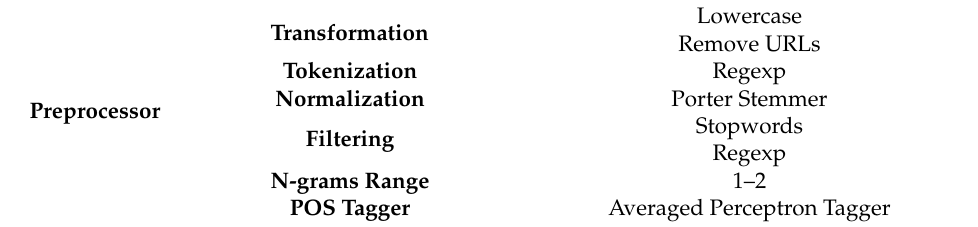
Table 3. Preprocessing